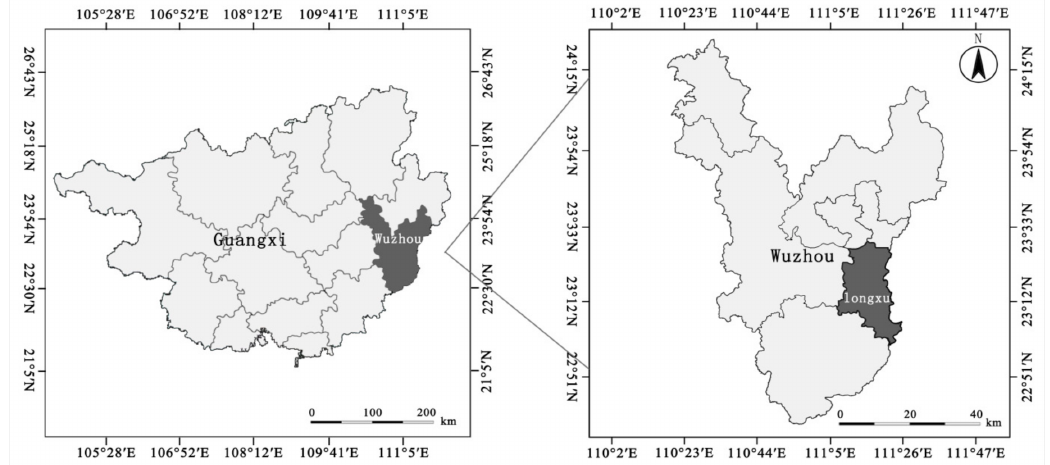
Figure 2. The location of the sampling